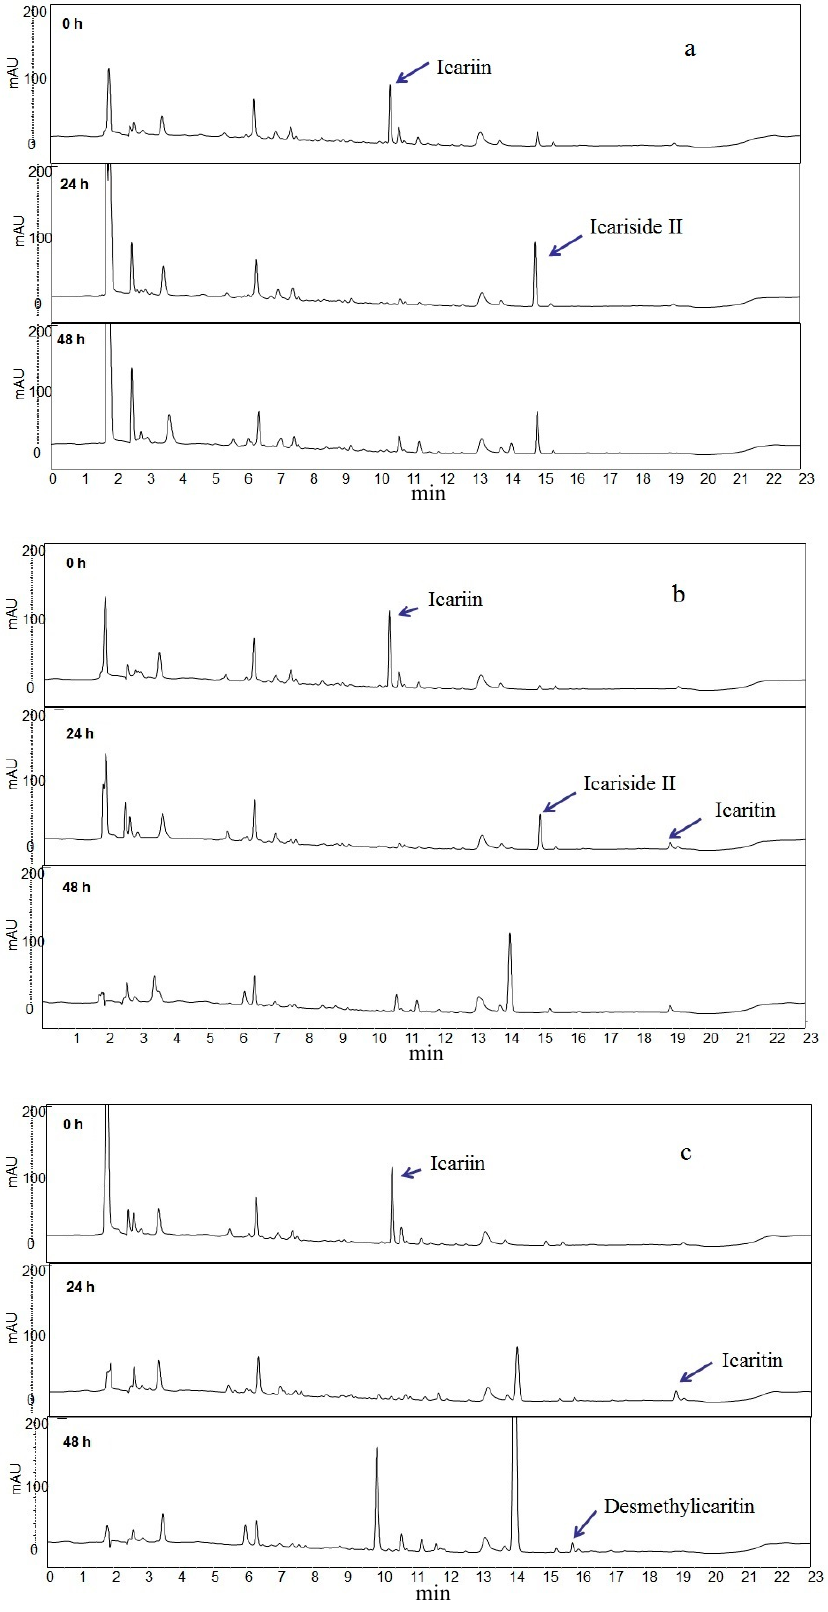
Figure 2. HPLC chromatograms of icariin biotransformation products. Each chromatogram was obtained from the different human intestinal microflora. Microflora a , b and c showed icariside II, icaritin and desmethylicaritin formation, respectively, after 48